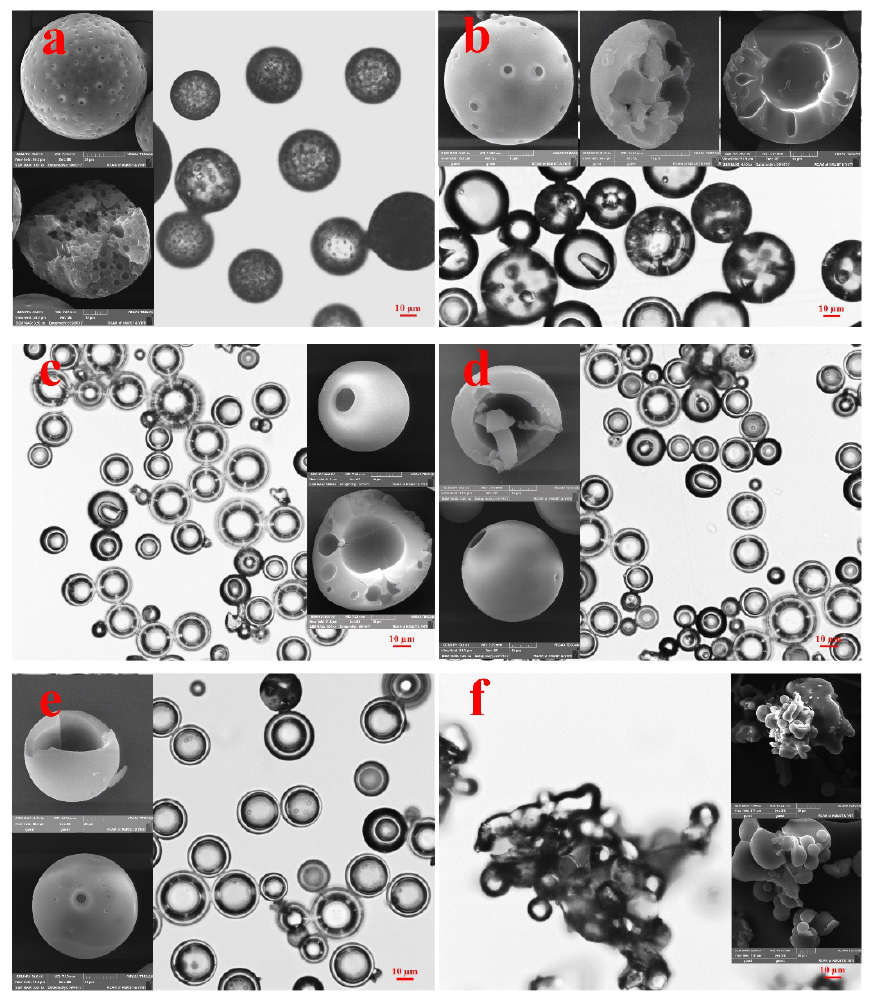
Figure 1. Optical microscope images and SEM images of PS microspheres prepared under varying experimental conditions: concentrations of EtOH at ( a ) 0, ( b ) 5.0 wt %, ( c ) 7.0 wt %, ( d ) 10.0 wt %, ( e ) 14.0 wt %, ( f ) 20.0 wt %.